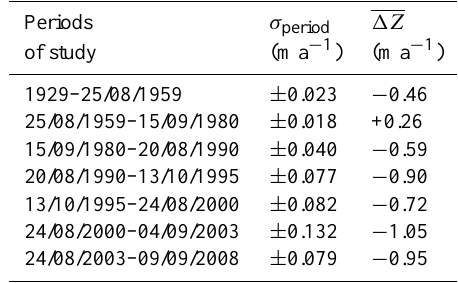
Table 2. σ period and 1Z for the geodetic volume changes calcula-